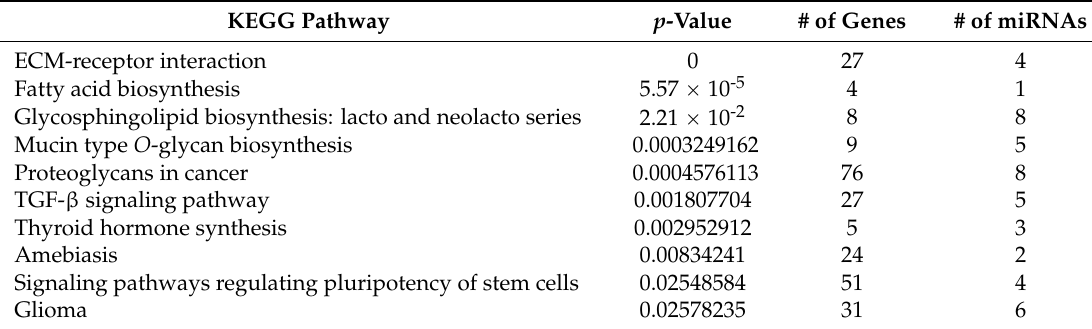
Table 7. Enriched KEGG pathways for predicted DDR targets of the microRNAs modulated by